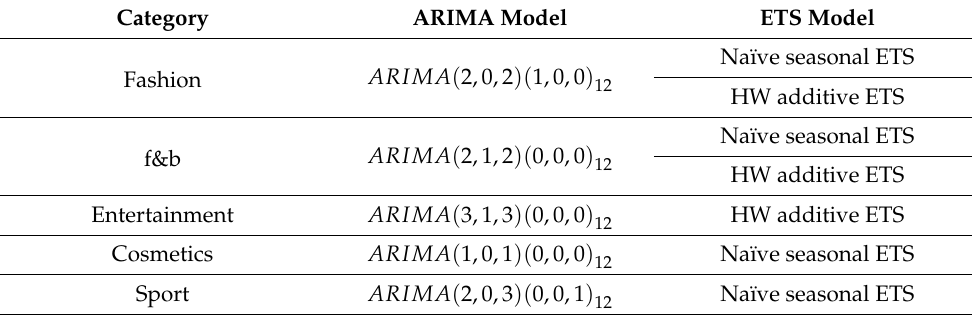
Table 4. Forecasting models for each retail categories.